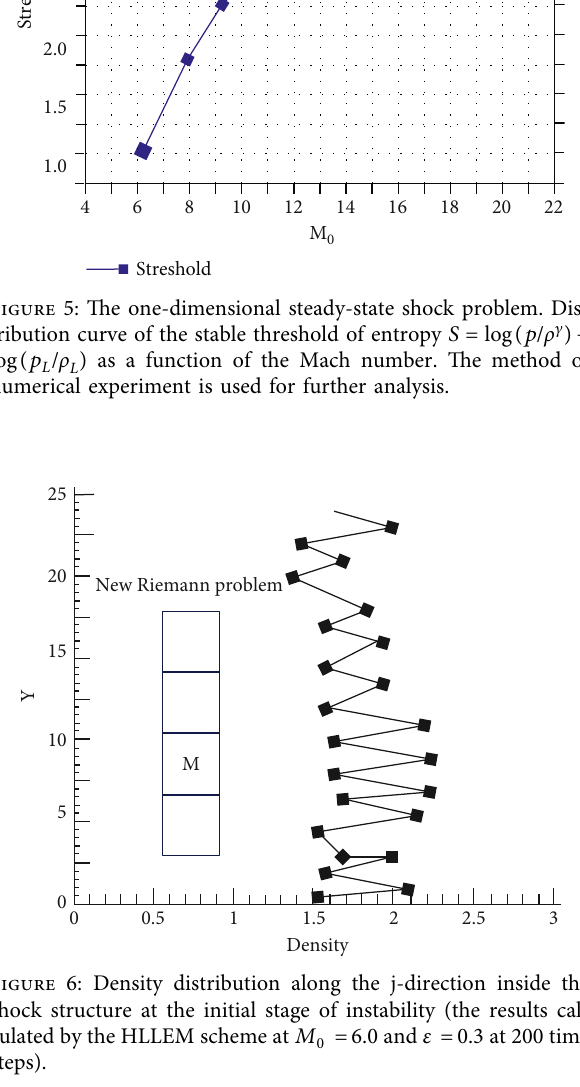
� 6.0 and ε � 0.3 at 200 time 0